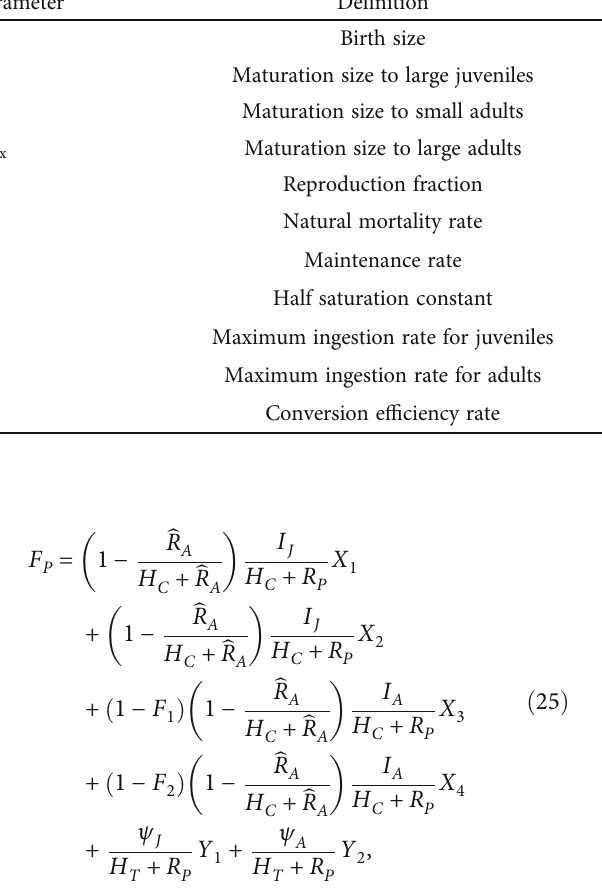
Table 5: Parameters for African cat fi sh, denoted X in our model description. MA is an abbreviation of model assumption.